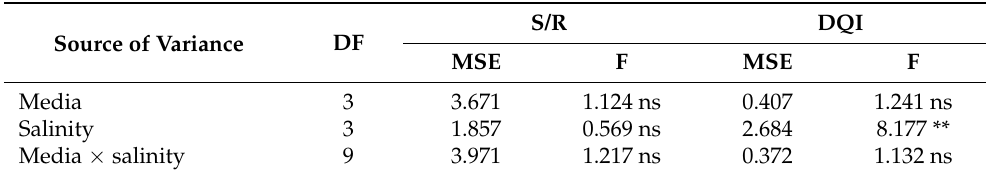
Table 4. Effect of medium and water salinity on shoot-to-root ratio (S/R) and Dickson quality index (DQI) of 14 week old Avicennia marina (Forssk.) Vierh. seedlings. S/R DQI Source of Variance DF MSE F MSE F Media 3 3.671 1.124 ns 0.407 1.241 ns Salinity 3 1.857 0.569 ns 2.684 8.177 ** Media × salinity 9 3.971 1.217 ns 0.372 1.132